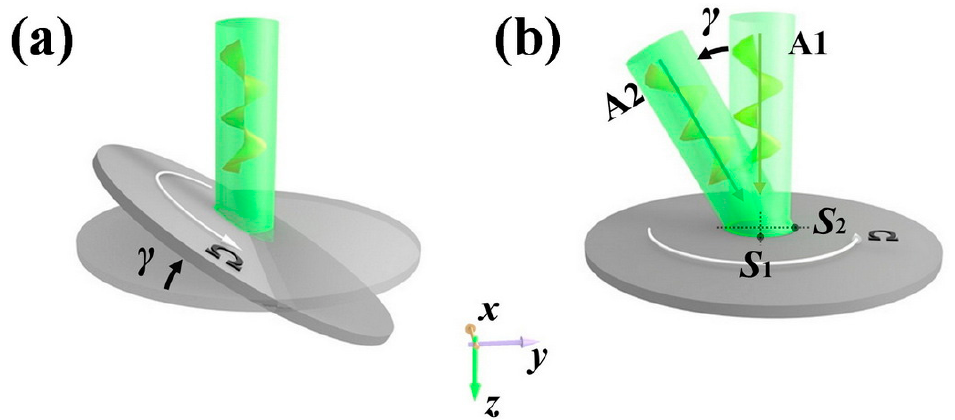
Figure 1. Schematic of probing rotating velocity of a tilted target. ( a ) Realistic scenarios with tilted rotor illuminated by OAM-carried light modes along z -direction; ( b ) equivalent conditions with non-inclination rotor illuminated by oblique OAM-carried light modes. Ω : rotating angular velocity of a rotor; γ : tilt angle, A1 and A2: optical axis of normal and inclined light beams; S 1 and S 2 : a target’s feature points in an elliptical light ring.